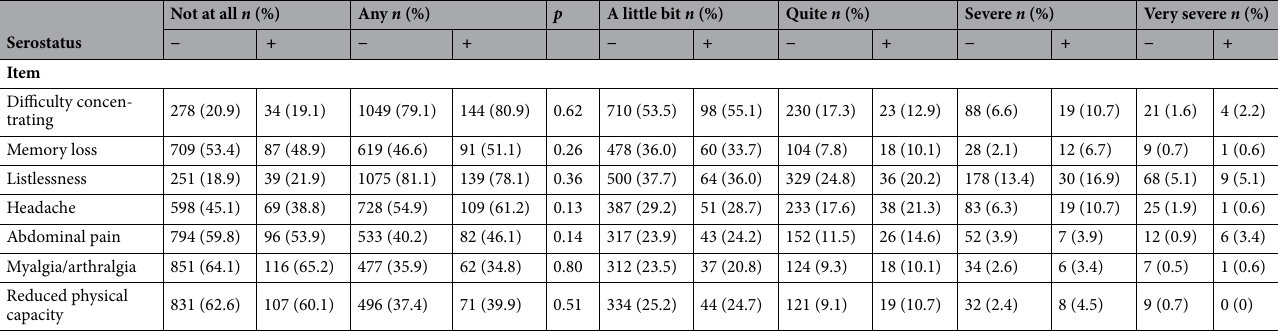
Table 1. Neurocognitive and pain results of seronegative (−) and seropositive (+) participants to the Long- COVID19-survey ( n (%); Fisher’s exact test: n = 1504).